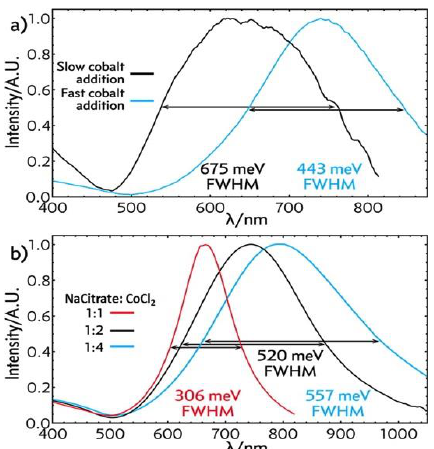
Figure 12. Monitoring gold nanoshell synthesis using UV-Vis absorption spectra: Mixing HAuCl 4 solution with Co nanoparticles with slow addition ( a ) (black curve) and fast addition (blue curve); and effect of varying rations of CoCl 2 and sodium citrate ( b ) (1:1, red; 1:2, black; 1:4, blue). Reprinted with permission from Reference [70]. Copyright (2014) American Chemical Society.